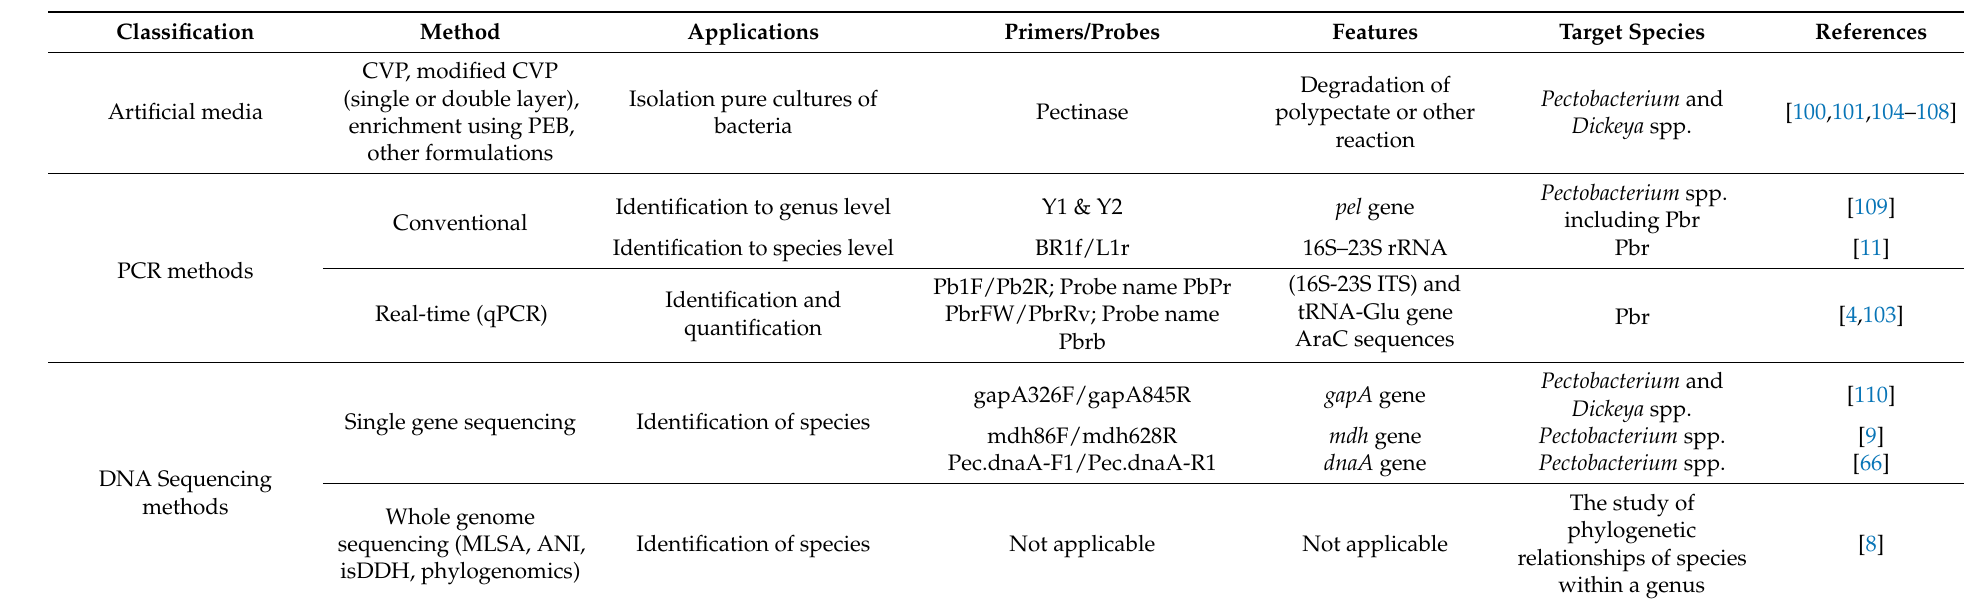
Table 2. Isolation and detection methods of